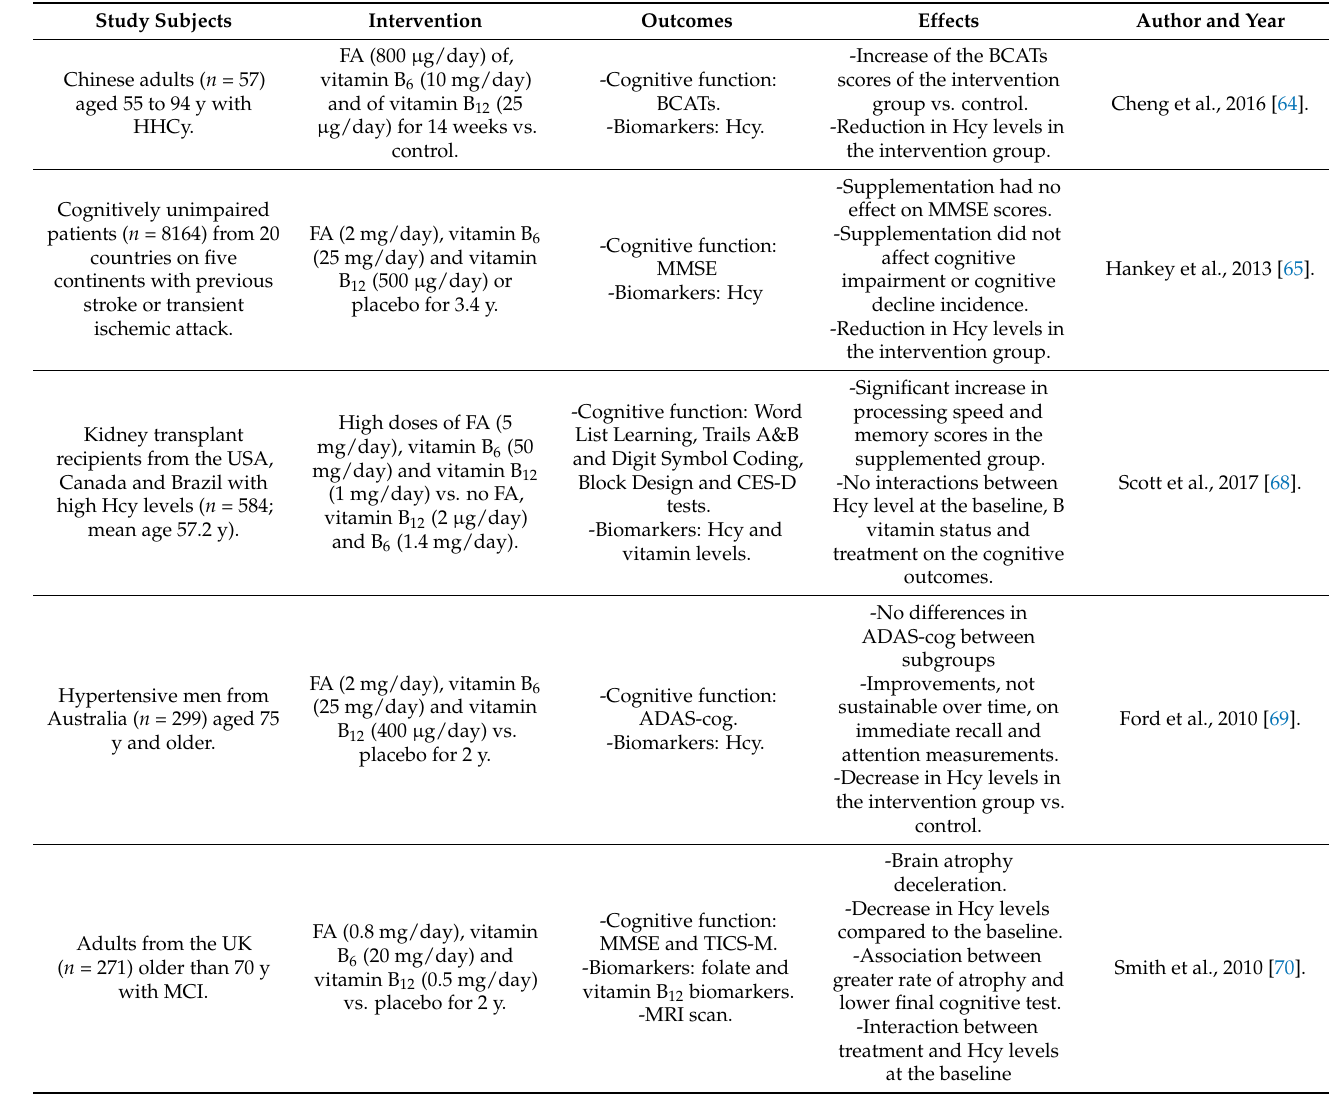
Table 3. Summary of the interventions based on folic acid and vitamins B 6 and B 12